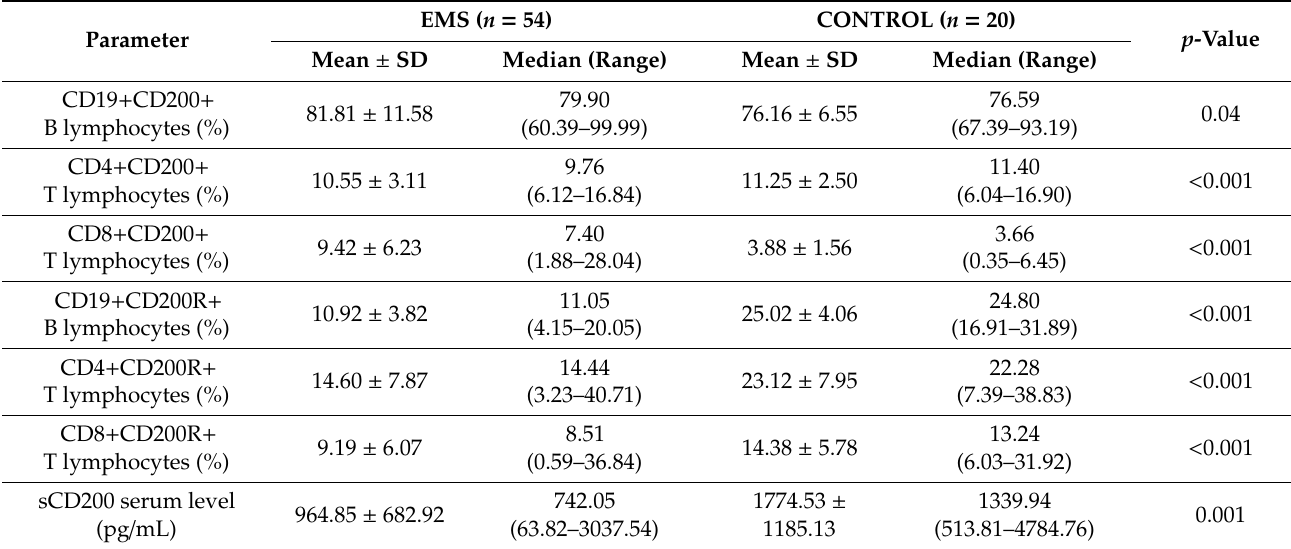
Table 3. The sCD200 serum concentration and frequency of CD200 and CD200R expression on T and B lymphocytes in EMS patients and